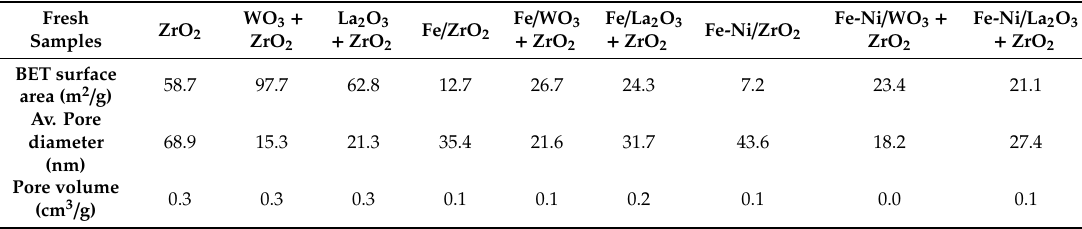
Table 1. N 2 adsorption-desorption results of the supports and synthesized samples.